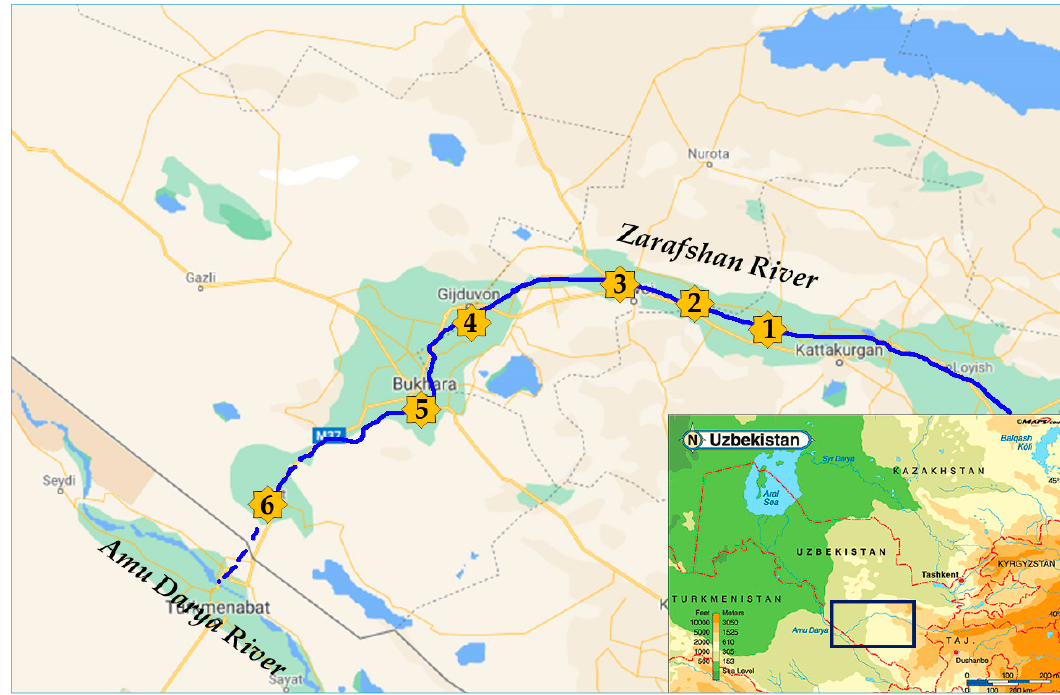
Figure 1. Map of diatom sampling points (orange stars numbered as in Table 1) in the Zarafshan River, 2009–2015. Table 1. Sampling points with GIS coordinates, distance from upper site, environmental and averaged biological